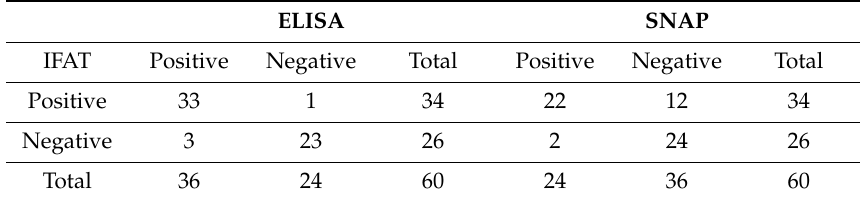
Table 6. Comparison of results obtained by IFAT, ELISA, and SNAP Leishmania test. ELISA SNAP IFAT Positive